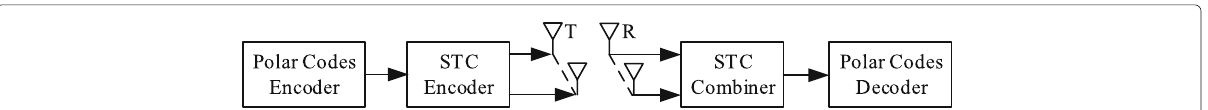
Fig. 2 Model of polar-coded STTD system. The running process of the concatenation of polar coding and STTD. It shows the overall delivery process of the information bits from the transmitter to the